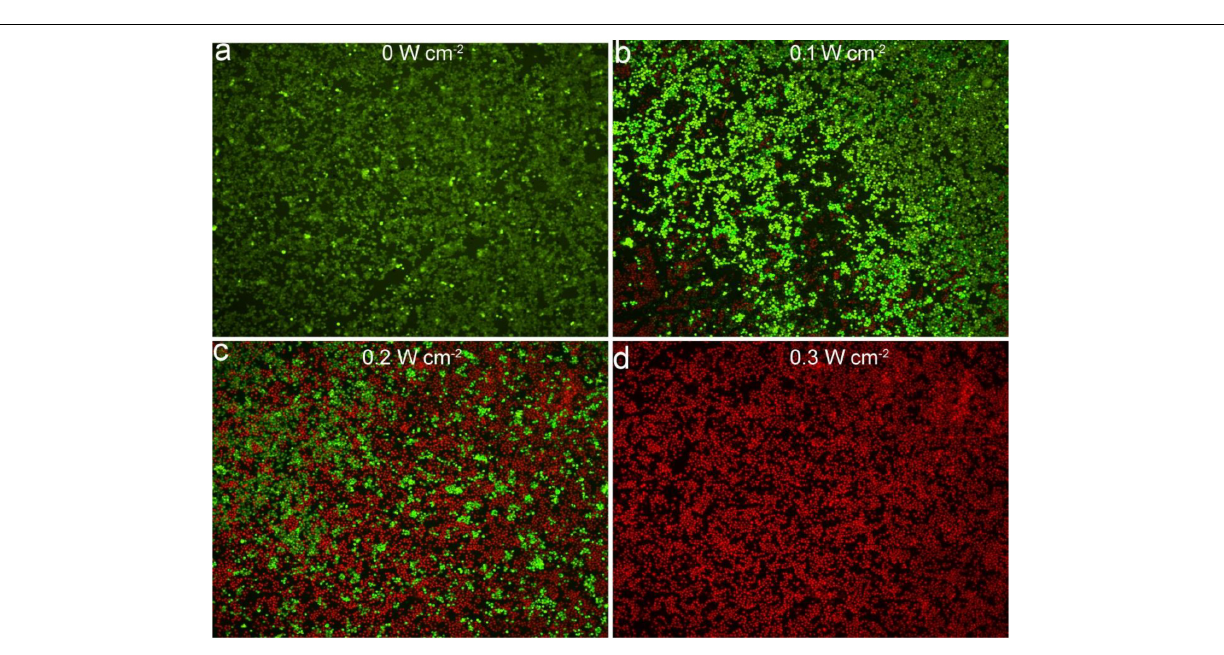
FIGURE 4 | Images of staining live/dead cells treated with an 808 nm laser at different power density. (a) 0 W cm - 2 . (b) 0.1 W cm - 2 . (c) 0.2 W cm - 2 . (d) 0.3 W cm - 2 . Magnification: 100